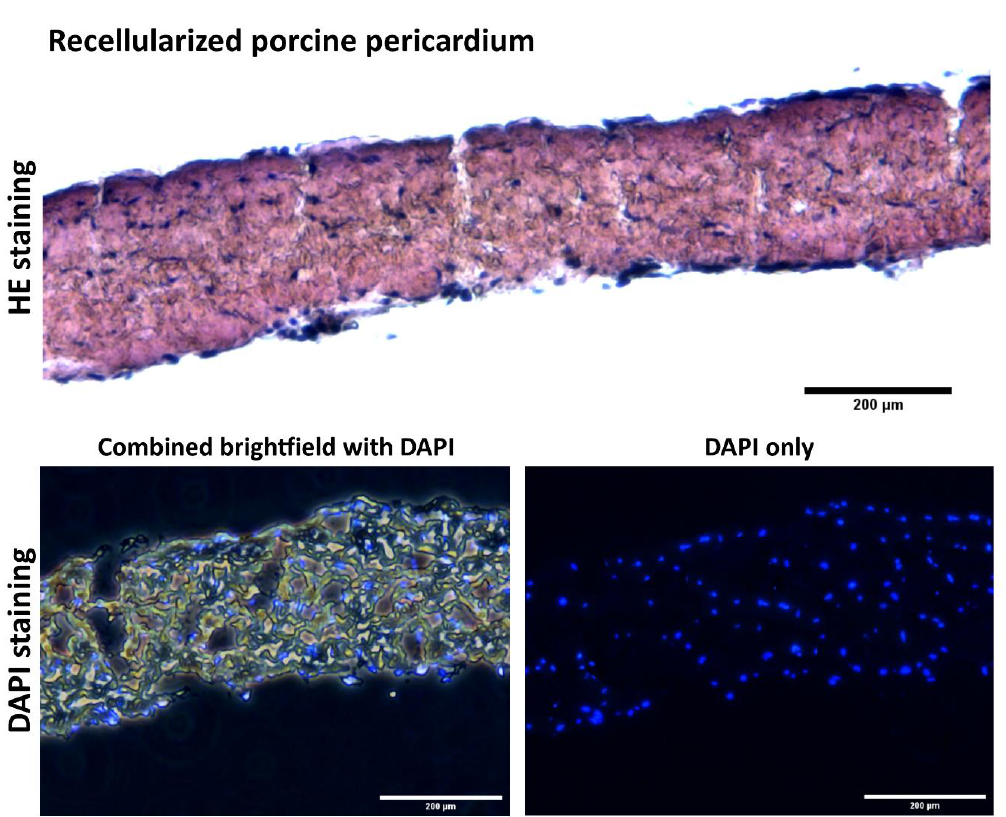
Figure 11. Paraffin-embedded 20 µm sections of porcine recellularized pericardium stained with hematoxylin-eosin (HE) and DAPI. Cells were seeded from both sides of the decellularized tissue prior to dynamic stimulation. Cultivation was held for 5 days in a dynamic culture system.